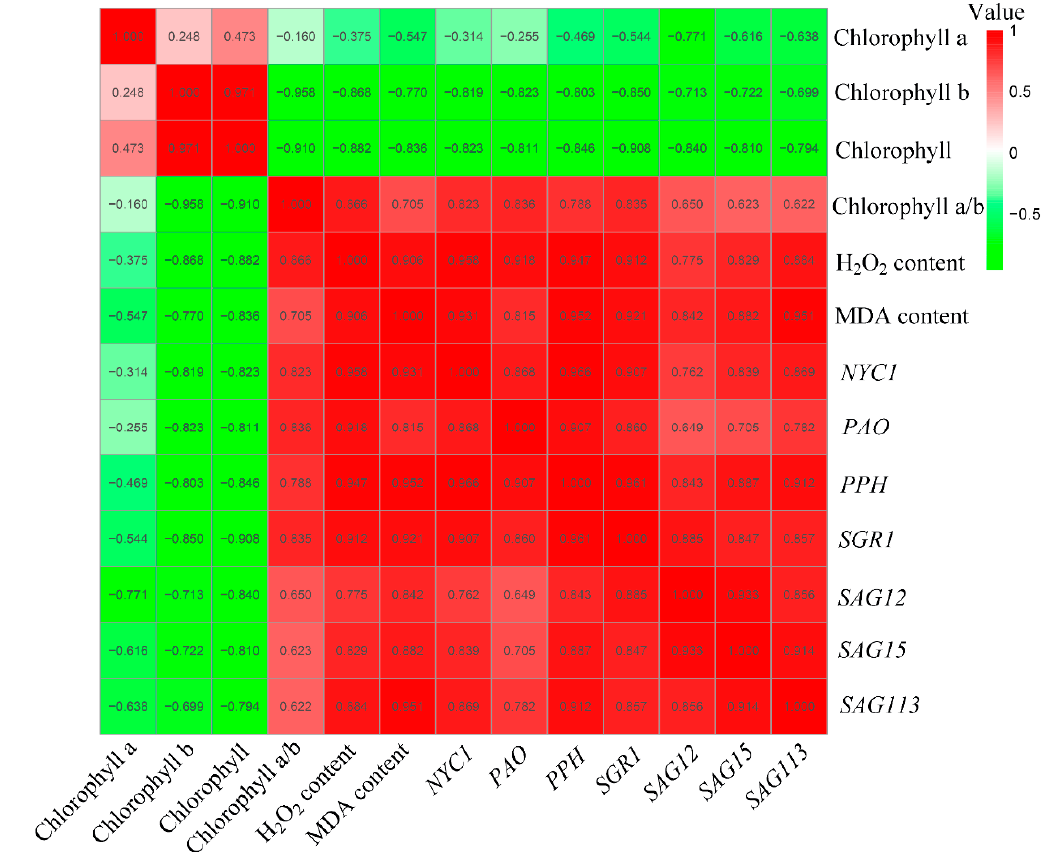
Figure 7. Correlation analysis among the parameters of chlorophyll, chlorophyll a, chlorophyll b, chlorophyll a/b, H 2 O 2 , malondialdehyde (MDA), and gene expressions of NYC1 , PAO , PPH , SGR1 , SAG12 , SAG15 , and SAG113 in detached leaves of 6-week-old wild-type, lcd1 , and LCD1-oe tomatoes stored in darkness for 0, 2, 5, and 8 days.